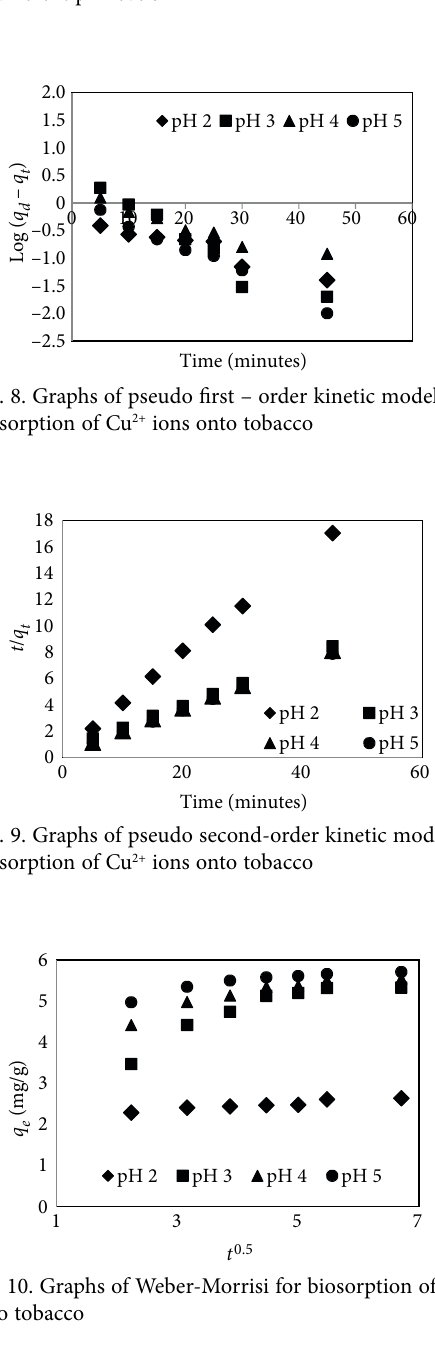
Fig. 7. Variation of biosorption capacity with contact durations at different pH